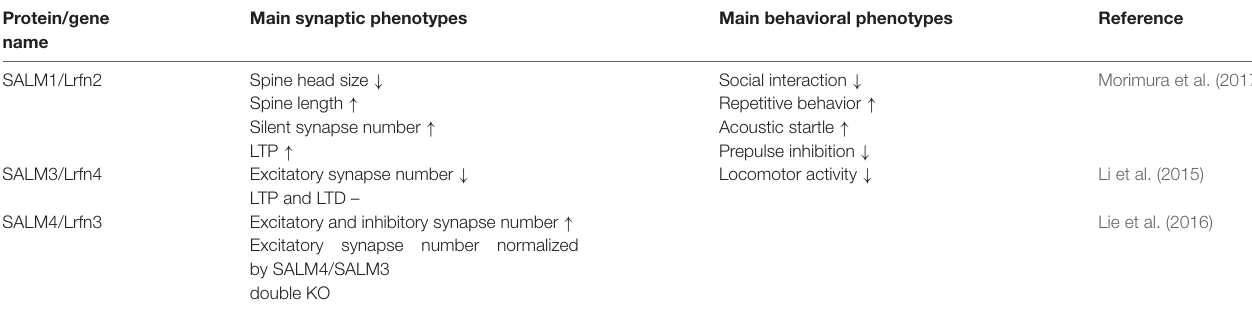
TABLE 2 | Main phenotypes of SALM/Lrfn-mutant